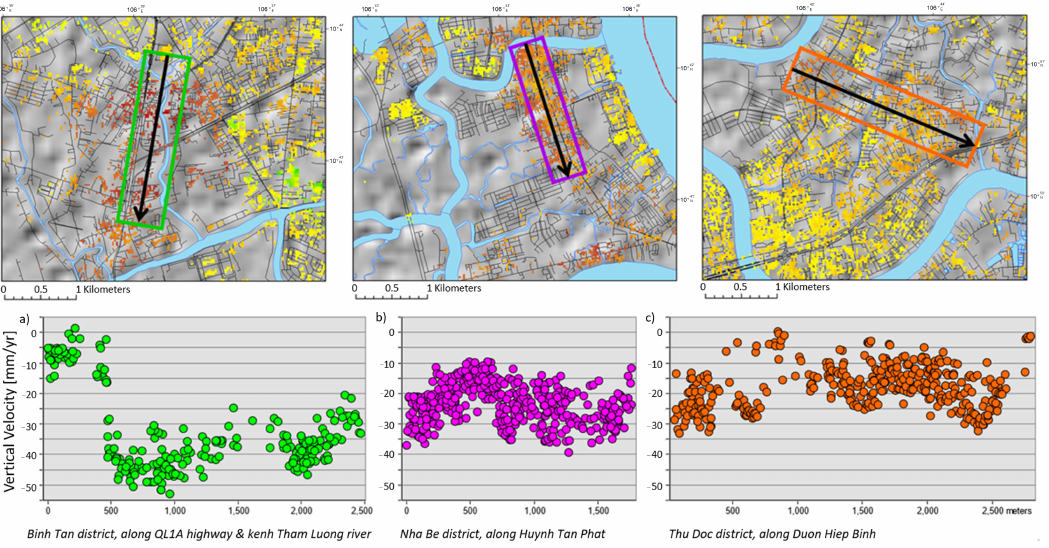
Figure 9. ( a – c ).Close-up subsidence rate maps and vertical velocity profiles of ( a ) a semi-industrial area of Binh Tan, ( b ) a relatively new residential area of Nha Be, and ( c ) existing urban area of Binh Thanh. The basemap is the CoastalDEM (90 m res) with OpenStreetMap local roads overlain. Colors of boxes correspond with spatial locations of bounding boxes found in Figure